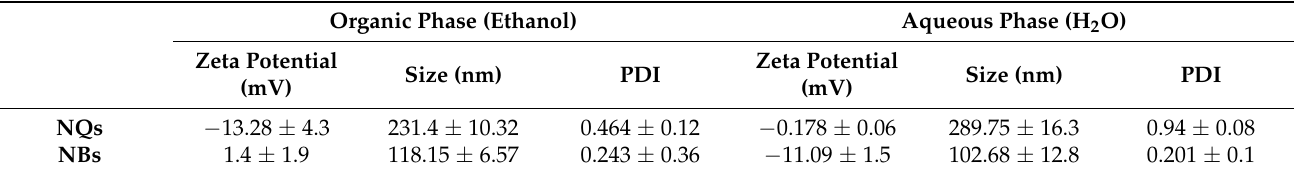
Table 3. Zeta potential, polydispersity index (PDI) and size of inulin nanoparticles loaded